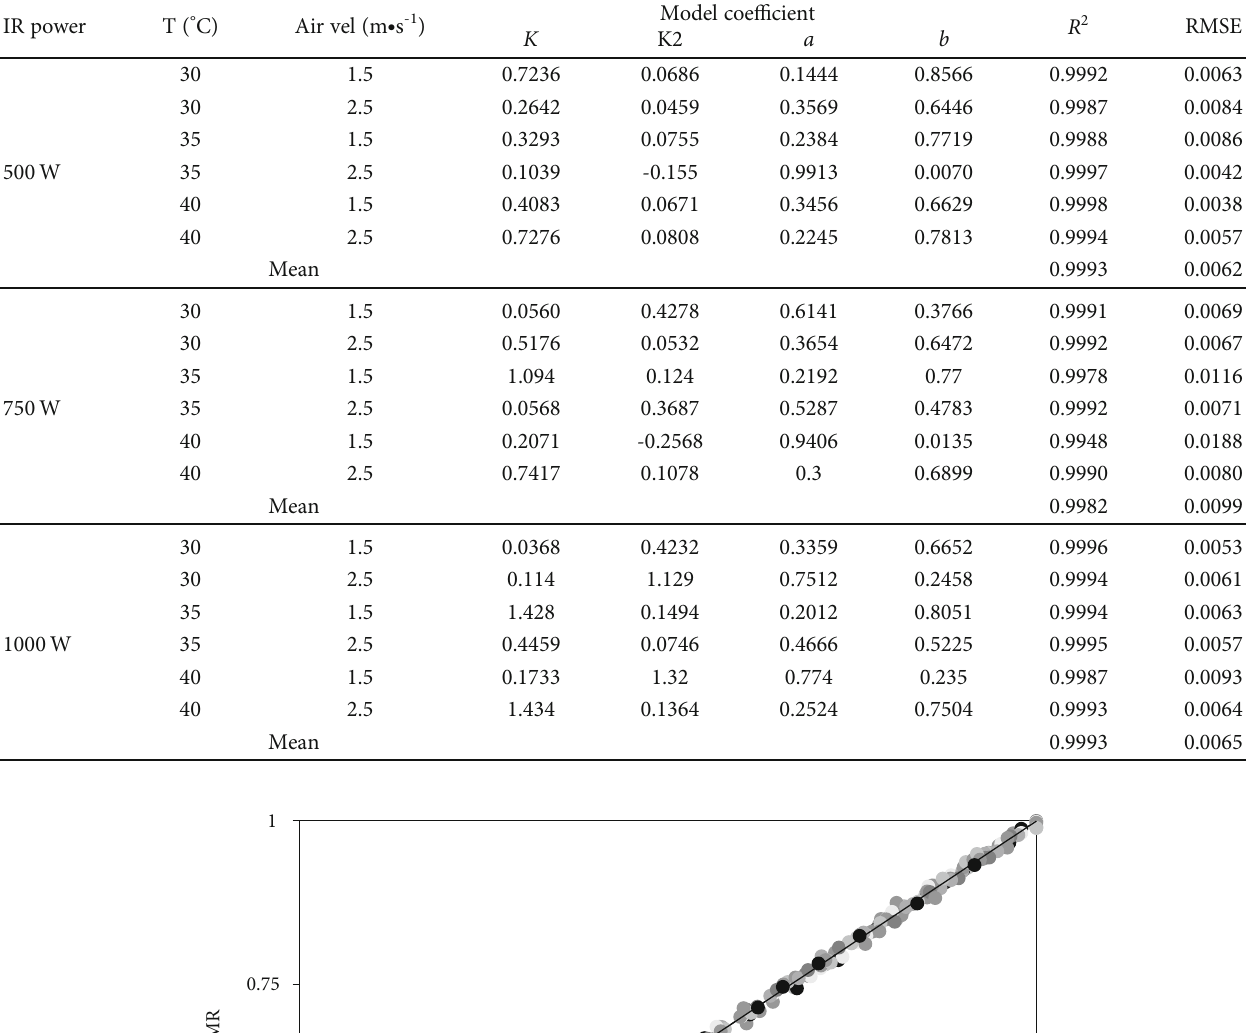
Table 7: Model coe ffi cient and statistical parameters for the two-term thin-layer drying model.